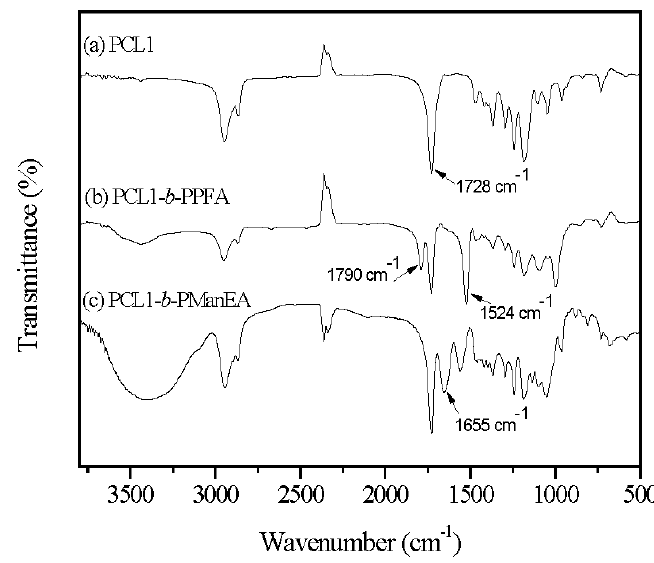
Figure 2. FT-IR spectra of: ( a ) PCL1 homopolymer; ( b ) PCL1- b -PPFA; and ( c ) PCL1- b -PManEA block copolymers.